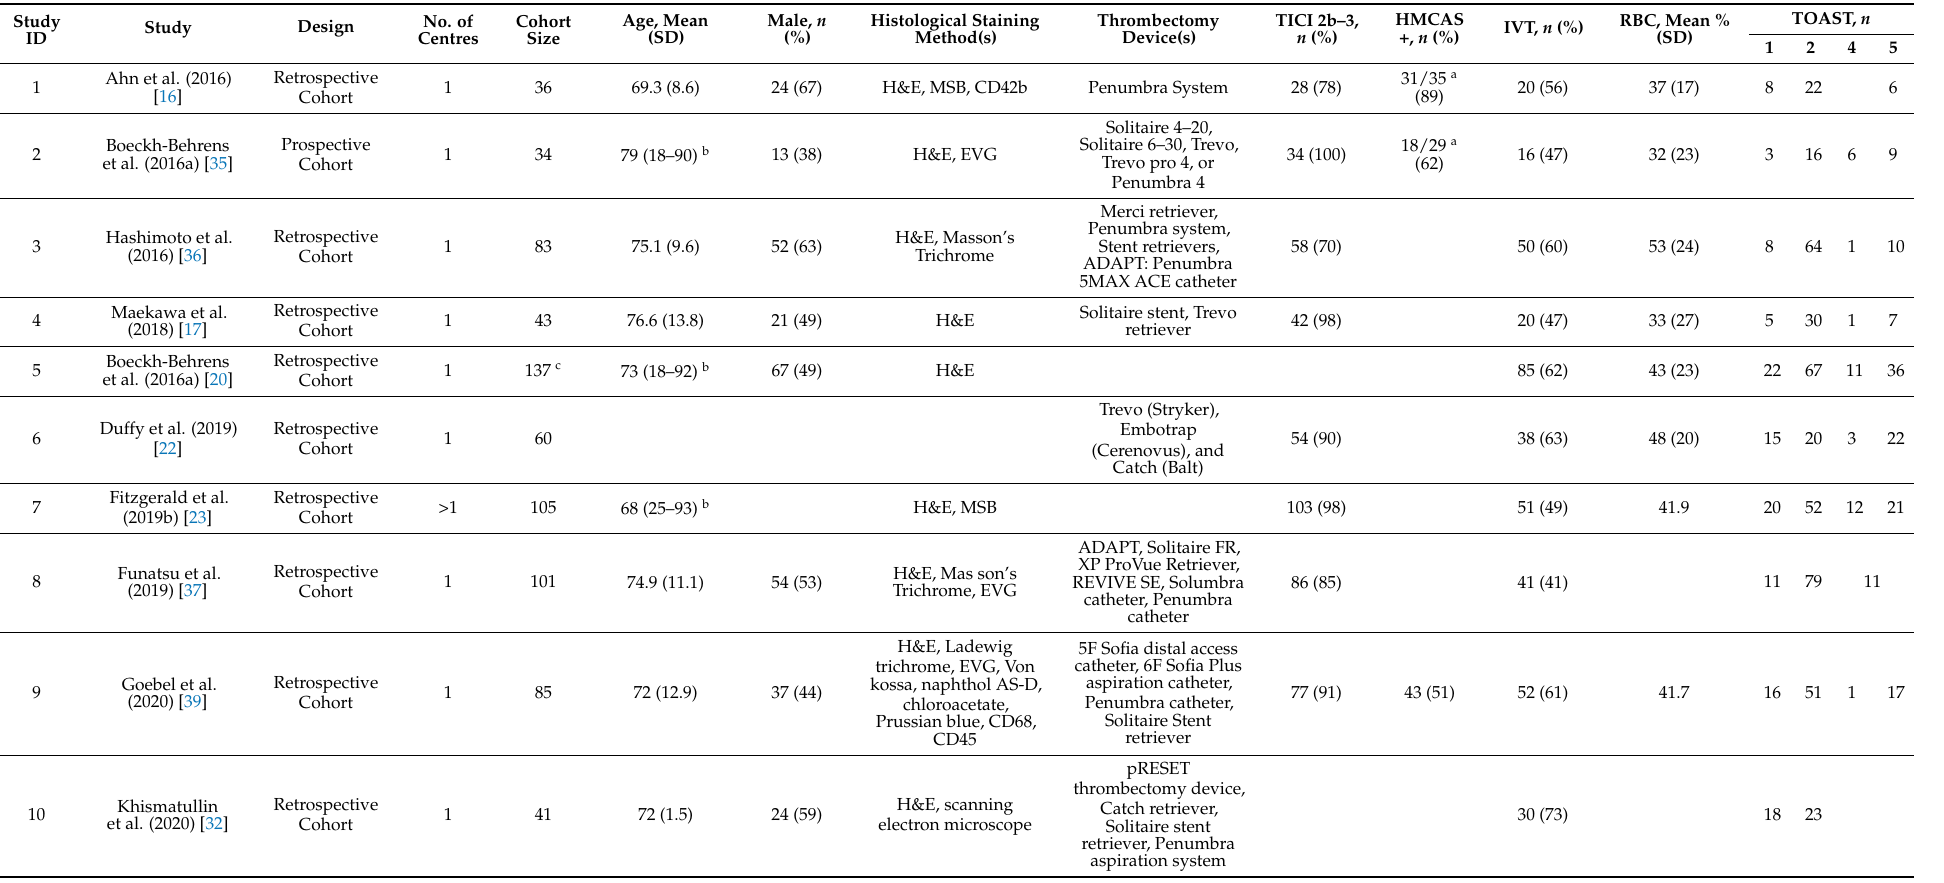
Table 1. Baseline Characteristics of Included